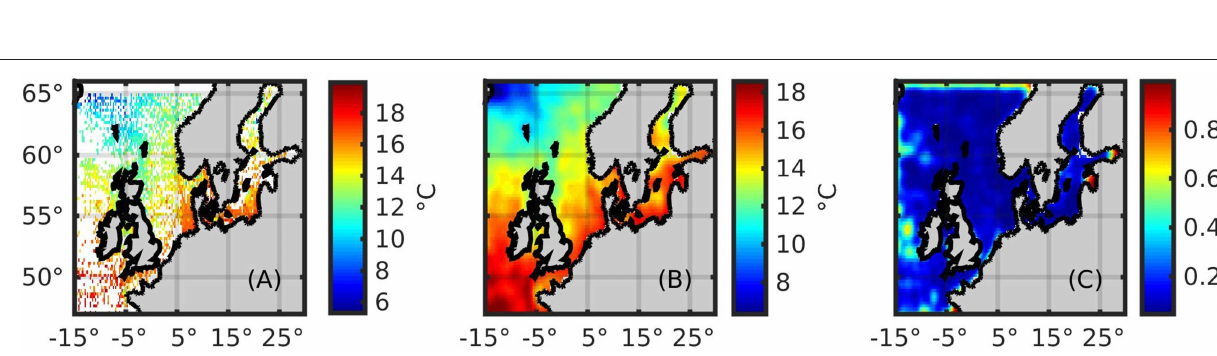
Frontiers in Earth Science |